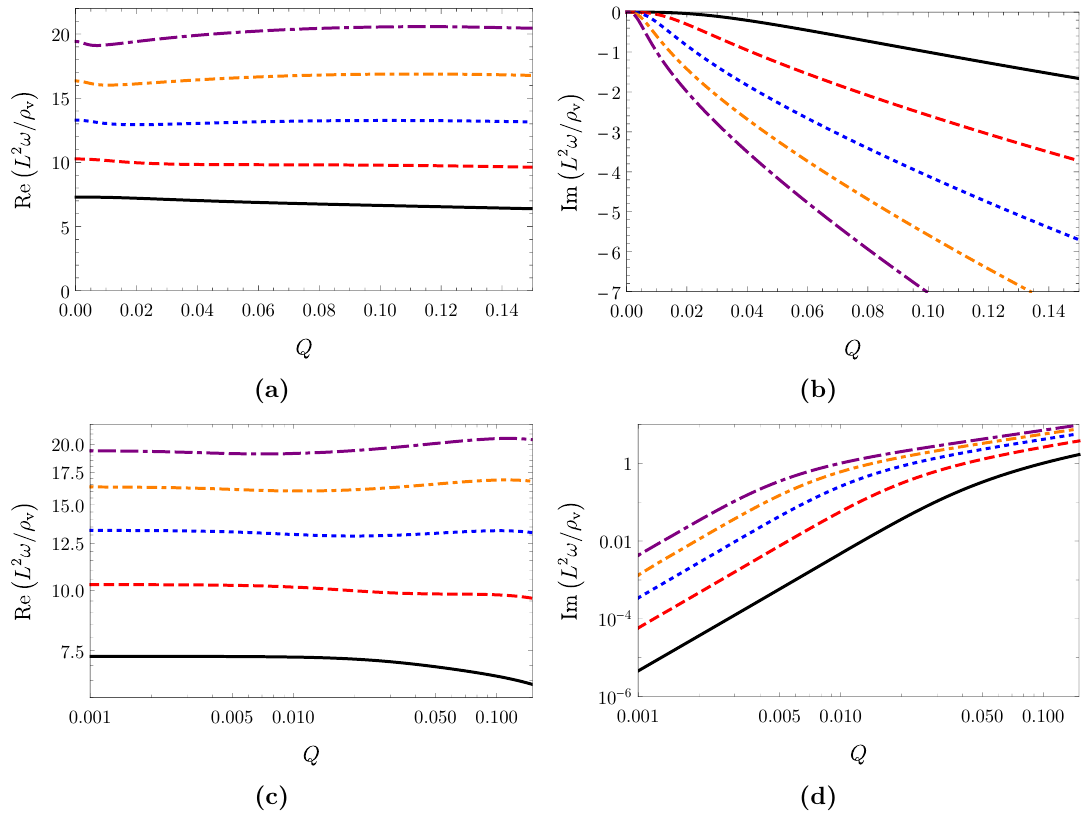
Figure 4. The real and imaginary parts of QNM frequencies of the (cid:13)uctuation (cid:26) 0 , in units of (cid:26) v =L 2 , as functions of Q . (a) and (b) have linear axes while (c) and (d) have logarithmic axes. The curves (solid black, dashed red, dotted blue, dash-dotted orange, dash-dash-dotted purple) are to guide the eye, and denote the same QNMs as in (cid:12)gure